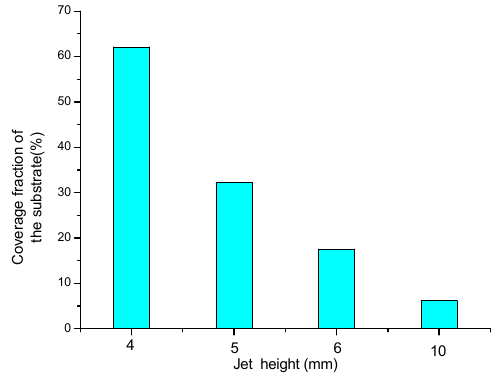
Figure 5. Relationship between jet height and coverage fraction of the substrate.